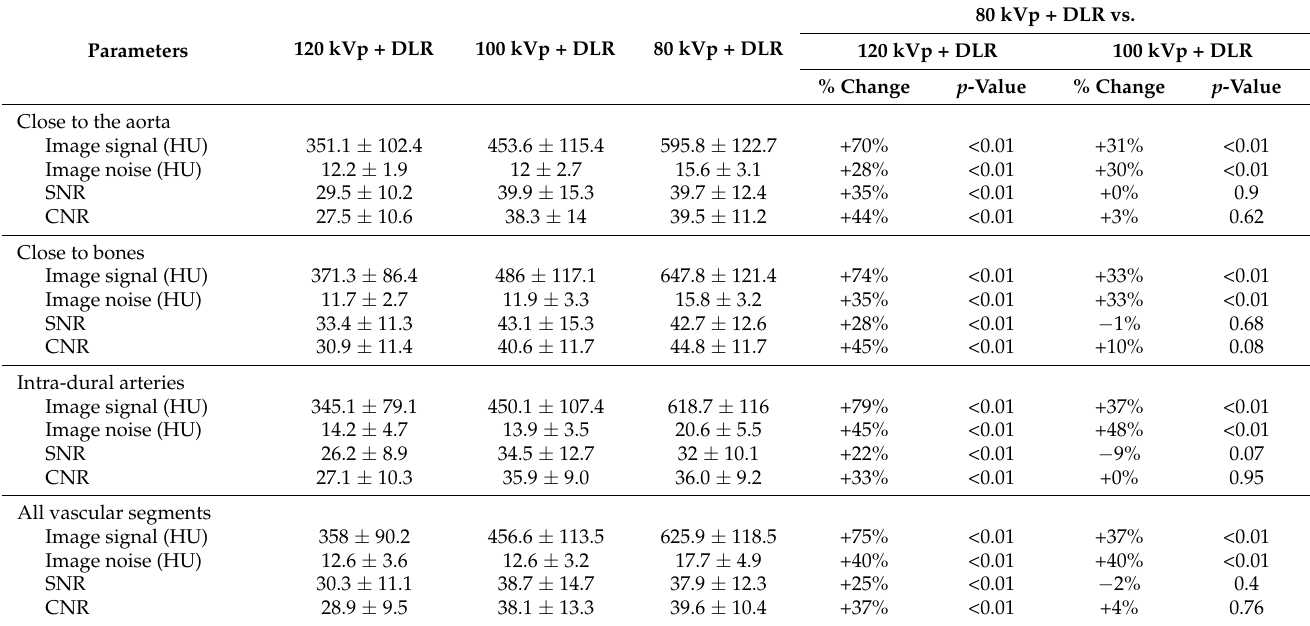
Table 5. Quantitative image analysis at regional levels of low-kVp protocol with DLR vs. higher-kVp protocol with DLR.